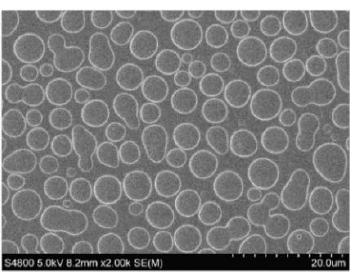
Figure 1. SEM image of the honeycomb-like arrays of polystyrene-b-poly(acrylic acid)/polystyrene (PS-b-PAA/PS) blends in tetrahydrofuran (THF) obtained by the breath figure (BF) method.